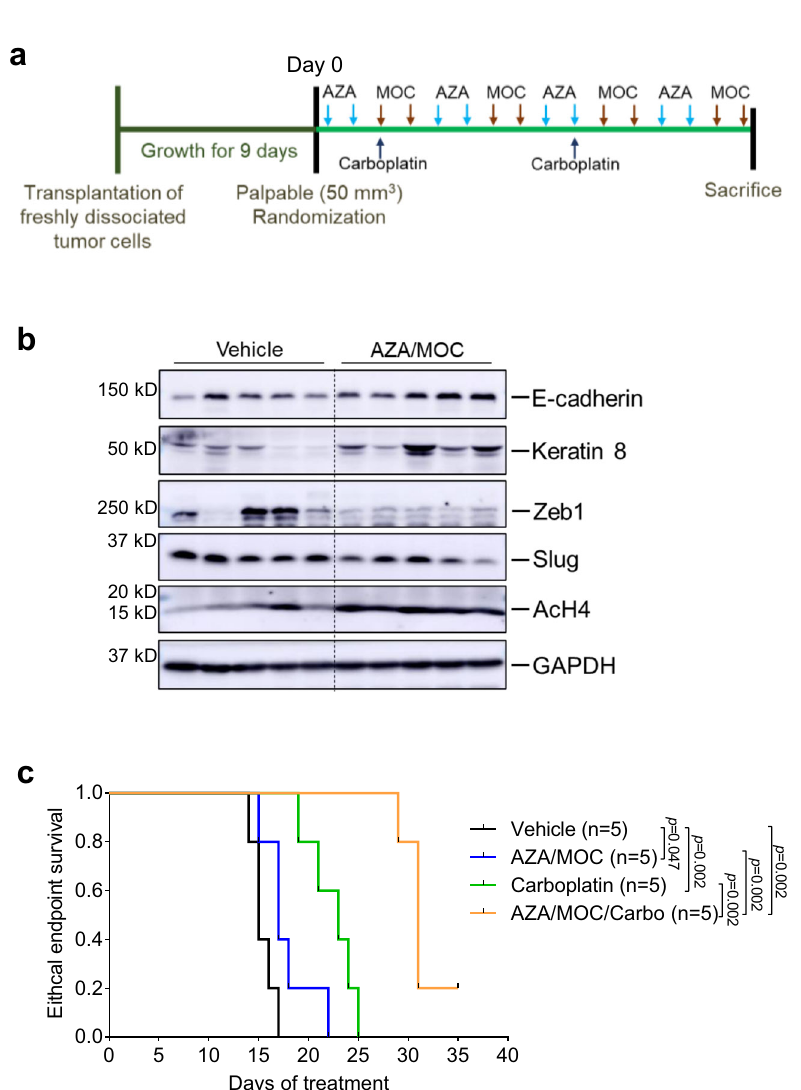
Fig. 6 Mocetinostat in combination with Azacytidine sensitizes mesenchymal tumors to chemotherapy. a Schematic of treatment schedule. Treatment is initiated when tumors are palpable. Mice are treated with Azacytidine (AZA) and Mocetinostat (MOC) in alternating 2-day cycles to avoid drug interference. Carboplatin is injected weekly. b Immunoblotting assay of T12 tumor tissues harvested at the ethical endpoint from mice that were treated with either vehicle alone or epigenetic therapies. n = 5 for each group. c Kaplan – Meier survival curve of T12 tumor-bearing mice from treatment start time (Day 0). The log-rank test (two-tailed) was used to test for the signi fi cant differences of Kaplan – Meier survival curves between groups. n = 5 for each classi fi cation label while still accounting for visual heterogeneity found across the control conditions 64,65 . Our collection of Trp53 -null GEM models displays signi fi cant